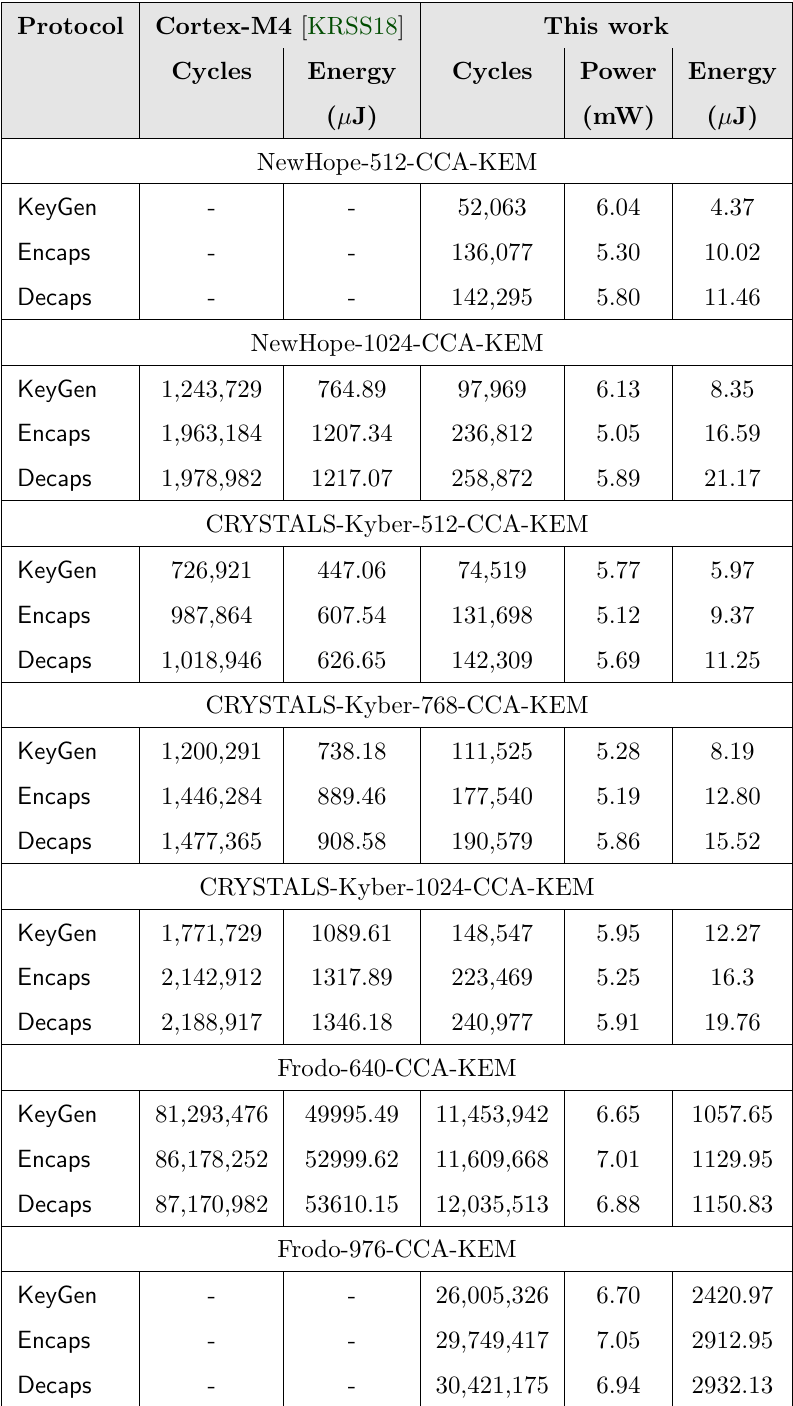
Table 8: Measured energy and performance of key encapsulation schemes